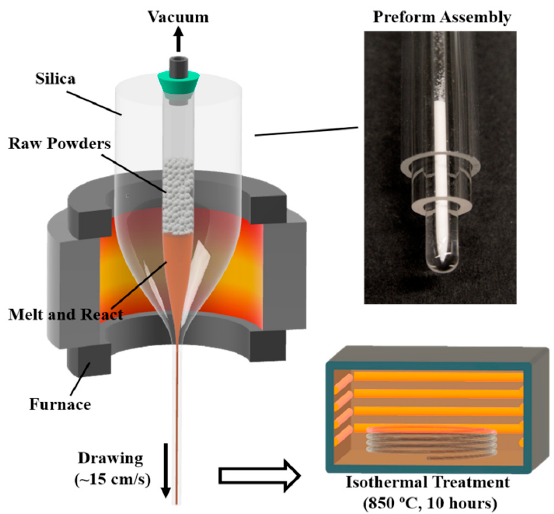
Figure 1. Preform assembly and fabrication procedure of BTS glass–ceramic fibers (BTS: BaO-TiO 2 -SiO 2